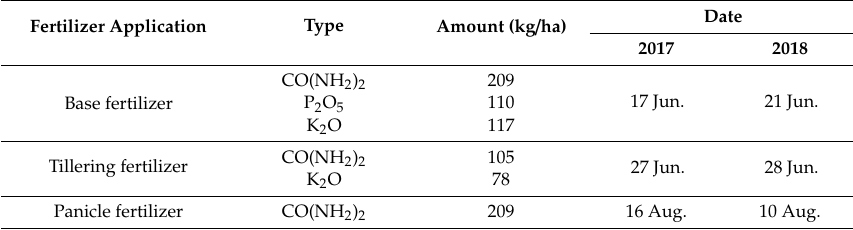
Table 2. Fertilizer application in 2017 and 2018.